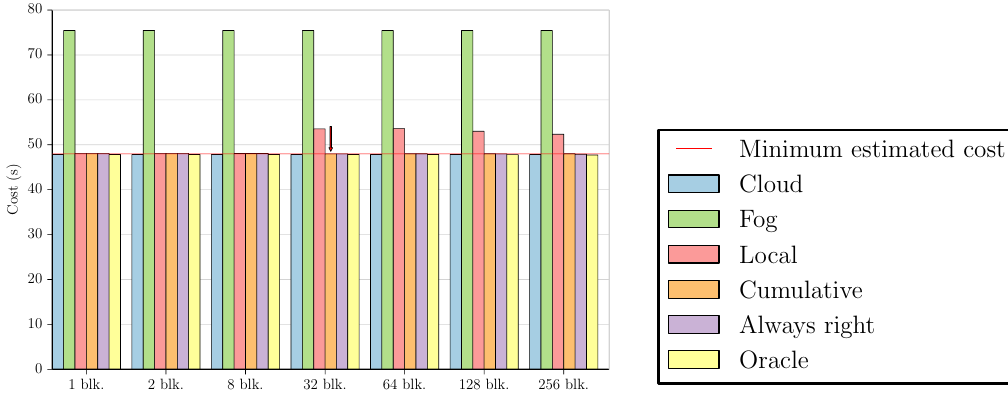
Figure 7. Summary of the results for MinMax [ − 5,5 ] cloud-prone test cases (HWBTempC).